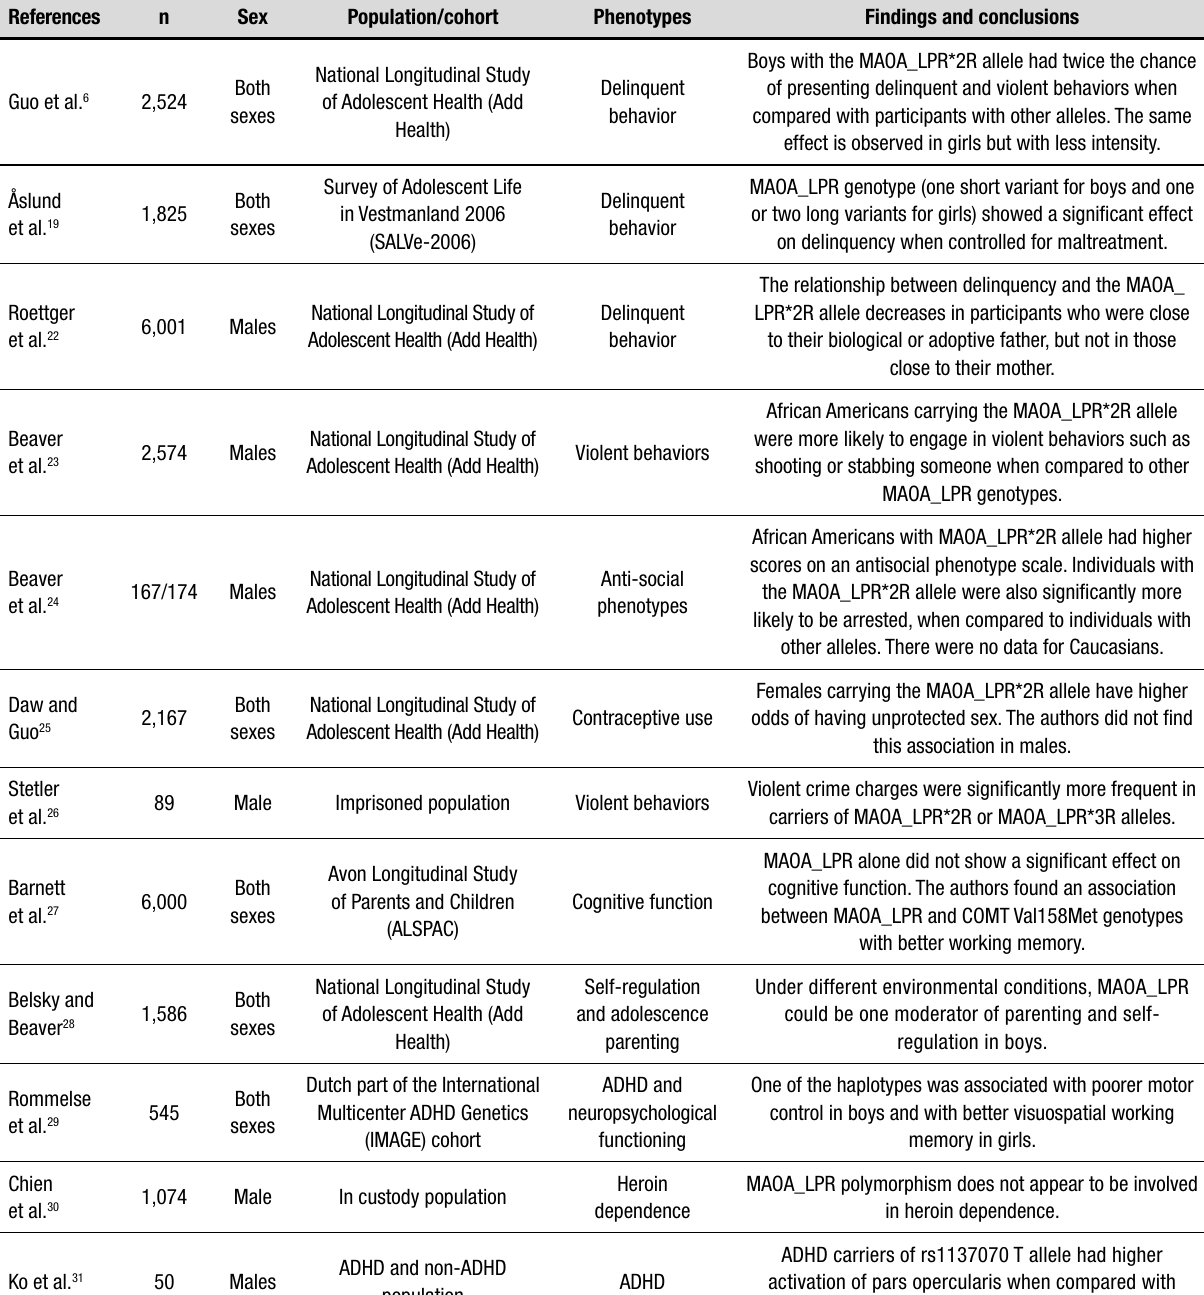
Table 1. Studies investigating the association between MAOA*2R and behavior disorders (PubMed search using MAOA, MAOA AND working memory, MAOA 2R, MAOA AND intelligence, MAOA 2-repeat